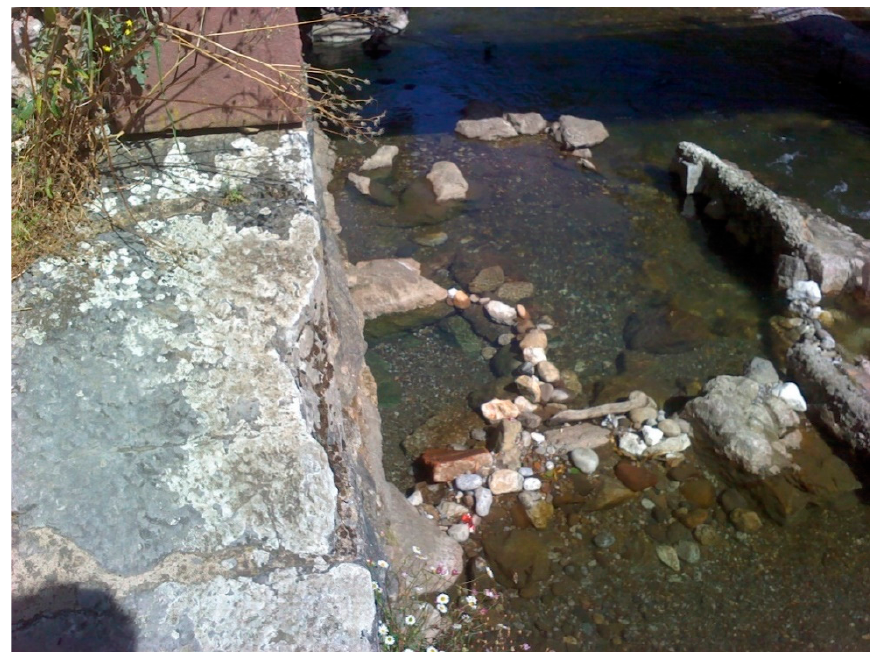
Figure 16. RGB image of the area with potential interest taken with a FLIR E40 handheld sensor to validate the final results.